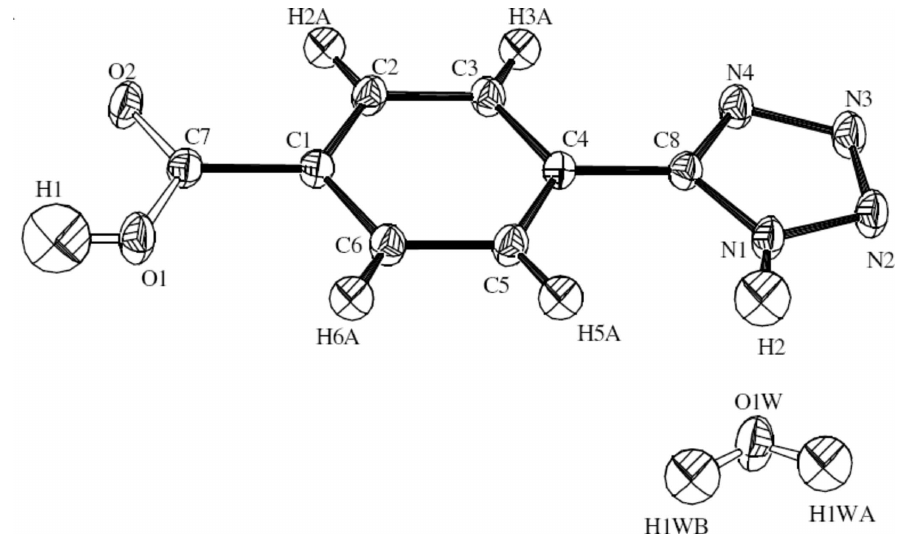
Figure 1 The molecular structure of I, with 30% probability displacement ellipsoids.